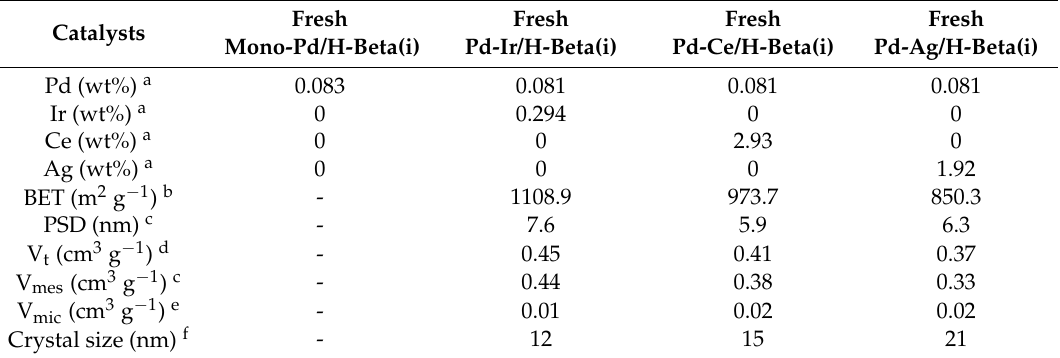
Table 2. Textural properties and optimum metal loading of the H-Beta(i)-based